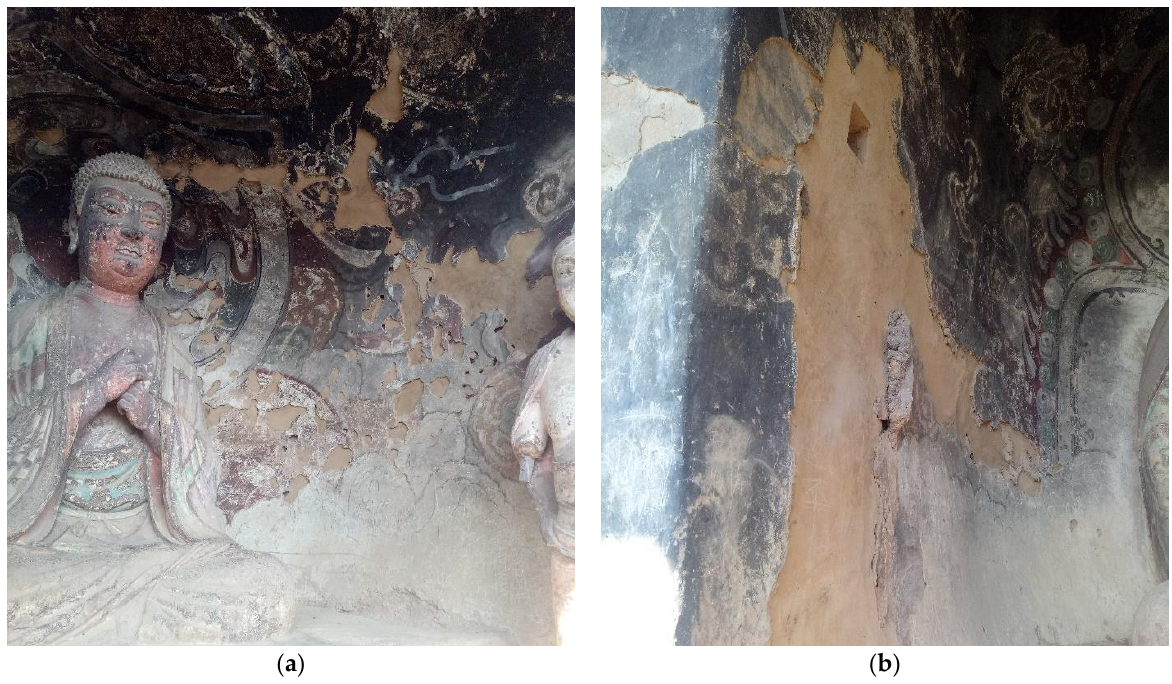
Figure 1. The efflorescence of Maiji Mountain Grottoes: detachment of the plaster layer ( a , b ).